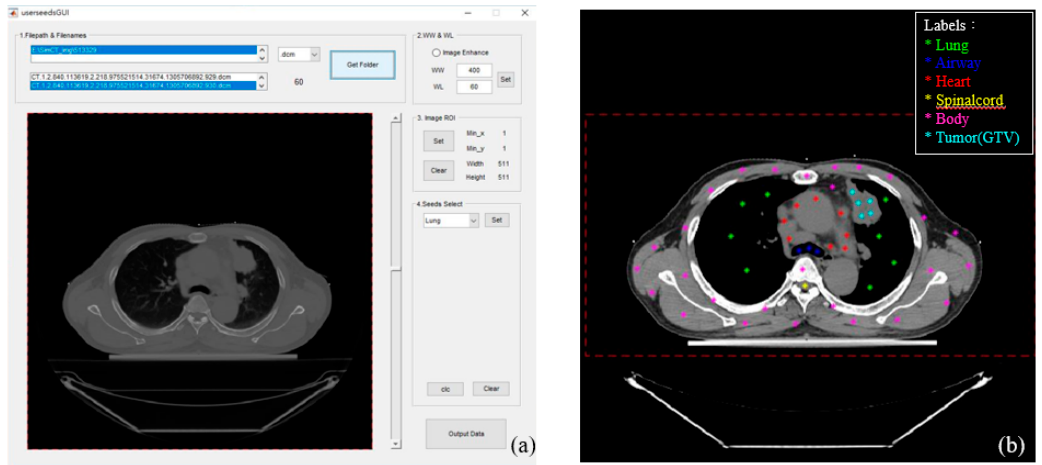
Figure 1. ( a ) The easy-to-operate GUI for users. ( b ) Initial seeds given by the user. A different color means a different category: lungs (green), airway (blue), heart (red), spinal cord (yellow), body (pink), the GTV (green-blue). The heart category contains the heart and its neighboring blood vessels (part of mediastinum having a similar HU to the heart).